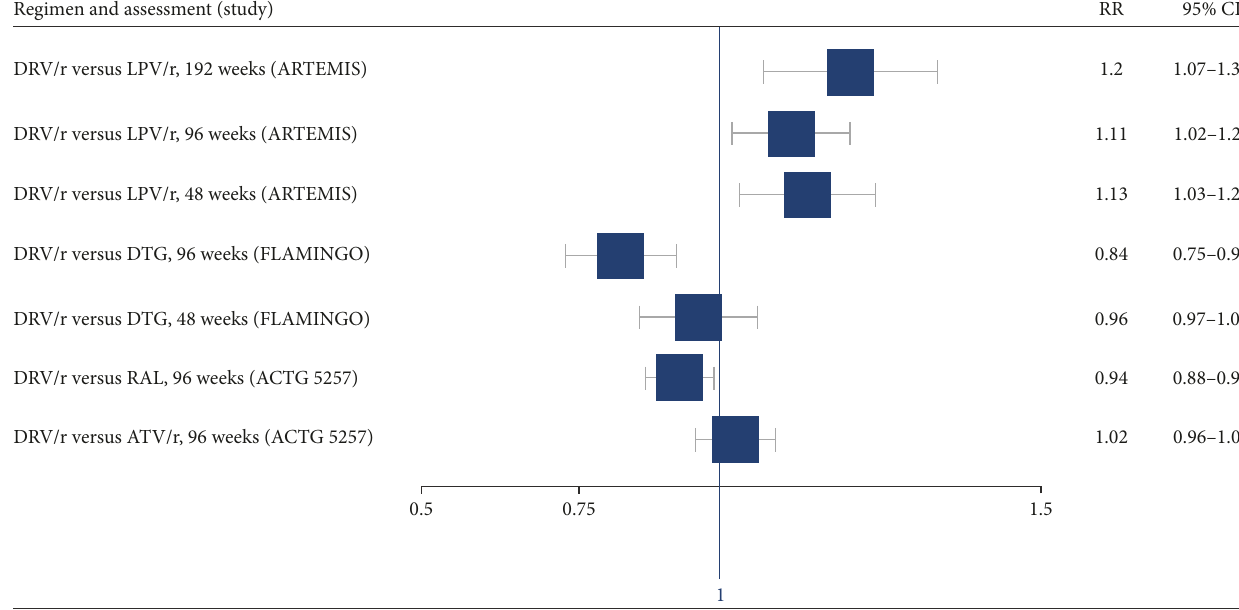
Figure 2: DRV/r-based regimens: efficacy in viral suppression, sorted by